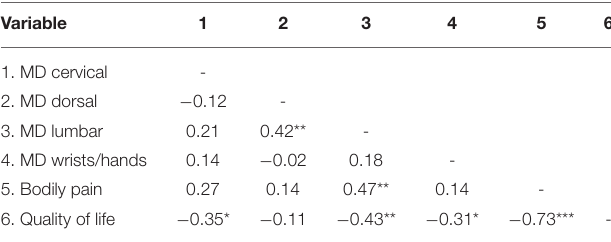
TABLE 2 | Correlation between musculoskeletal disorders, bodily pain, and health-related quality of life.